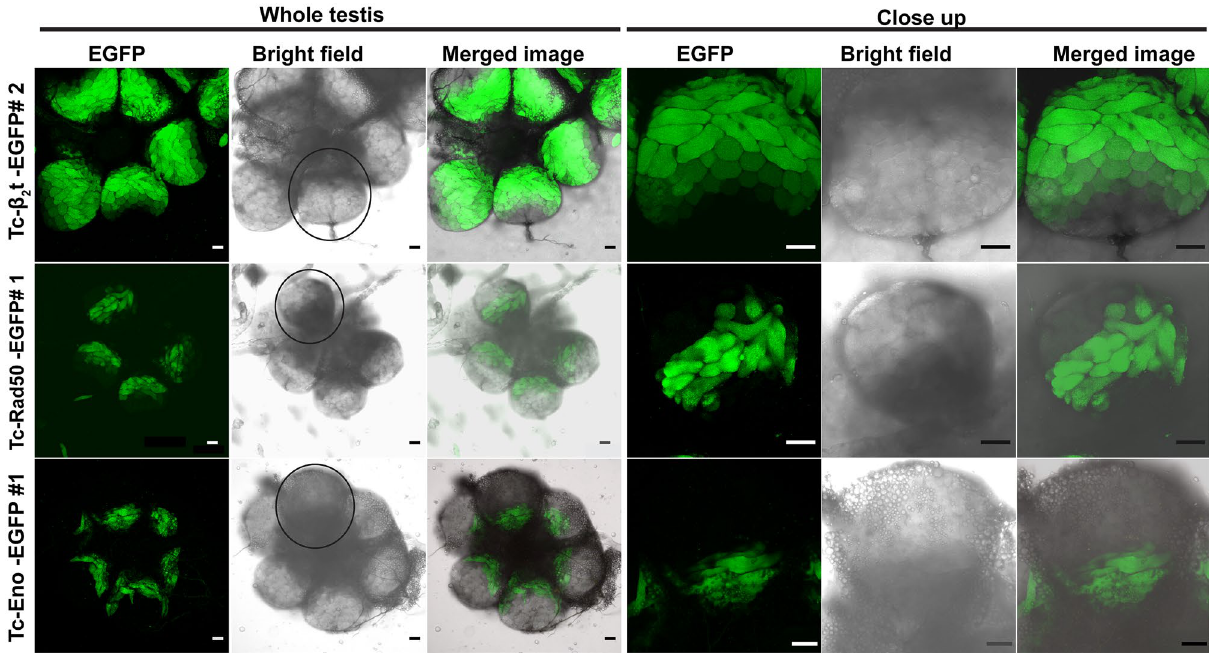
Figure 8. Confocal analysis of EGFP expression in transgenic male gonad. Expression of EGFP from transgenic males in whole testes and close up of single spherical testis dissected from Tc-β 2 t-EGFP#2, Tc-Rad50-EGFP#1, and Tc-Eno-EGFP#1 beetles. Black circle around the area in the whole testis corresponds to the close up image. Scale bar indicates 50